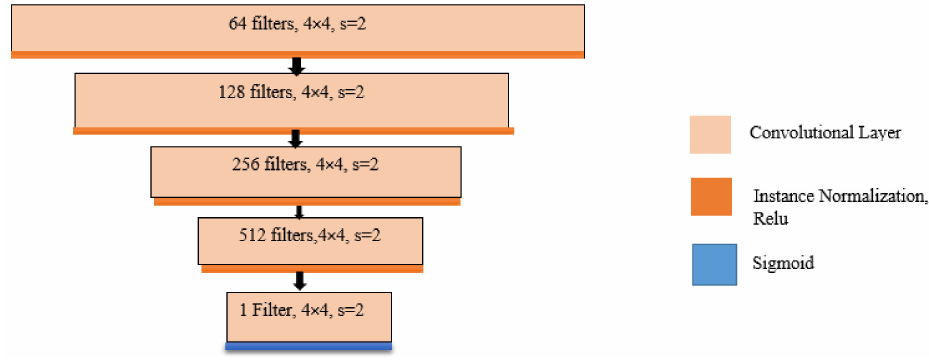
Figure 6. Generator architecture.